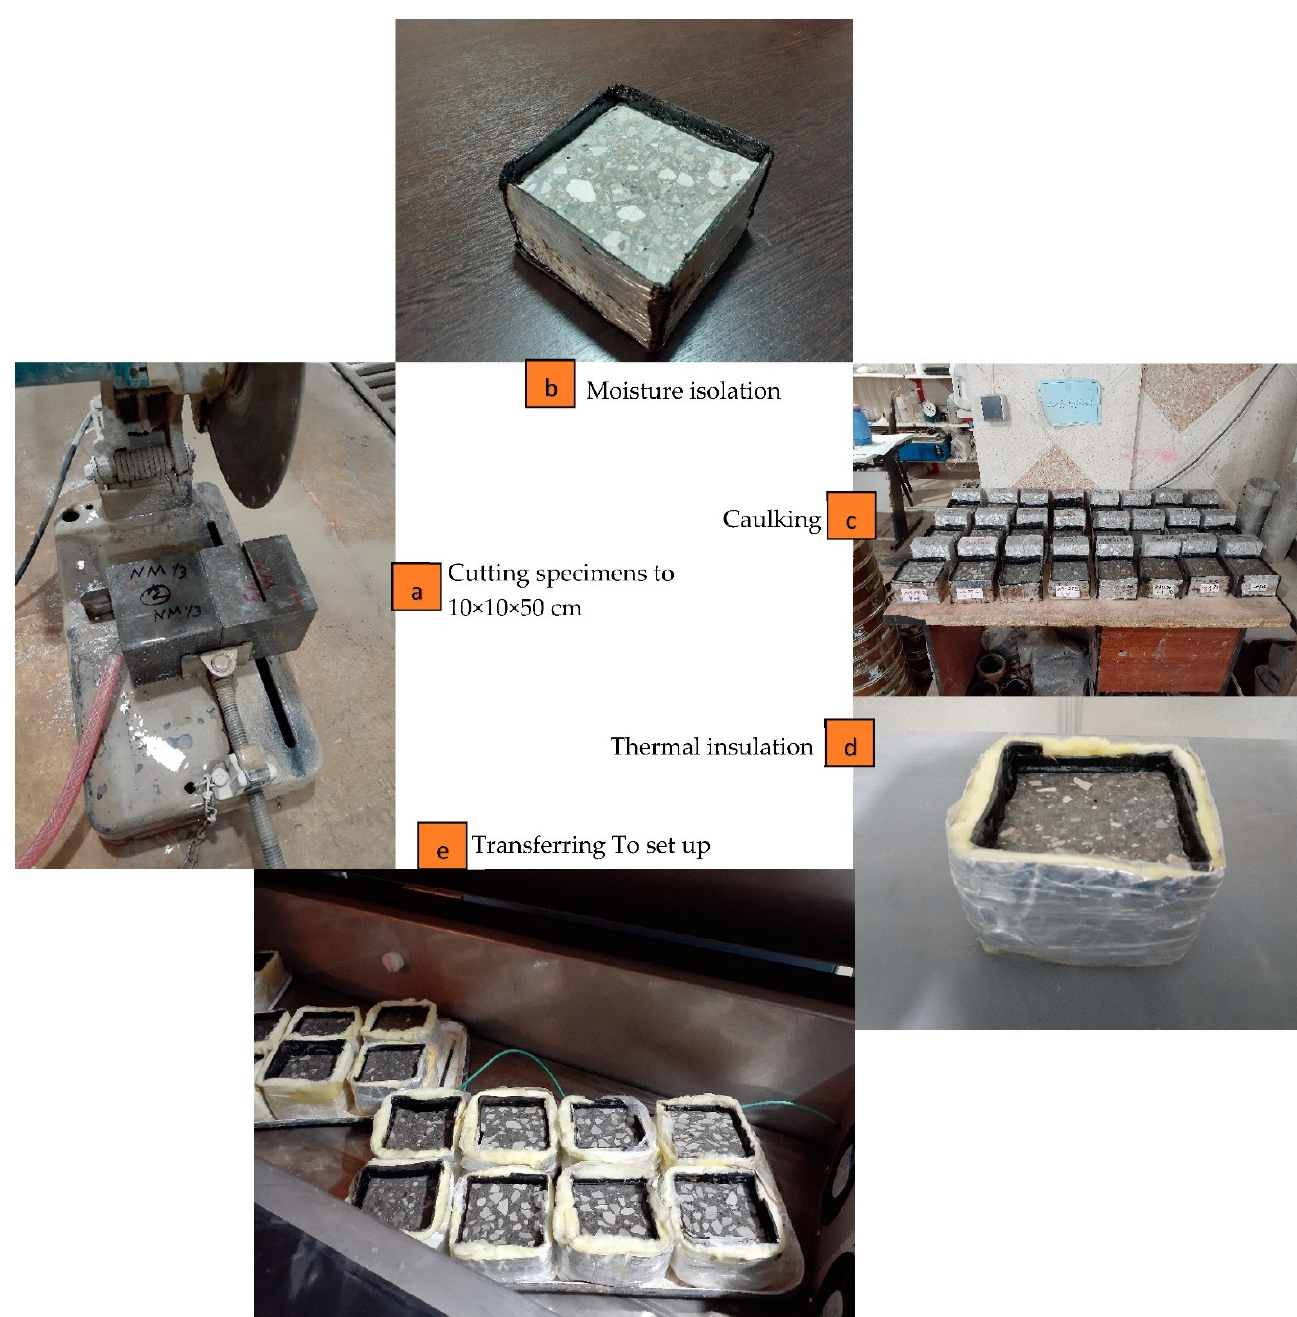
Figure 5. Preparation stages of freeze-thaw test samples.